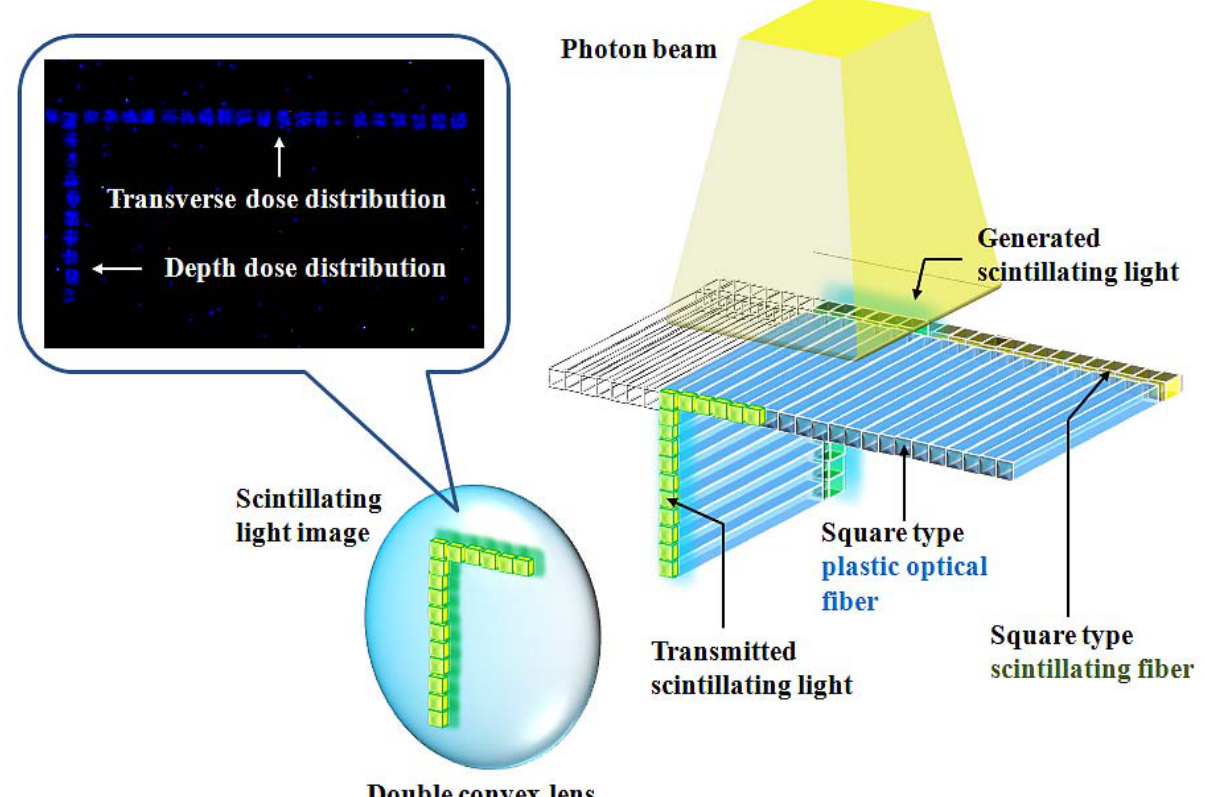
Figure 3. Scintillating light image of the fiber-optic